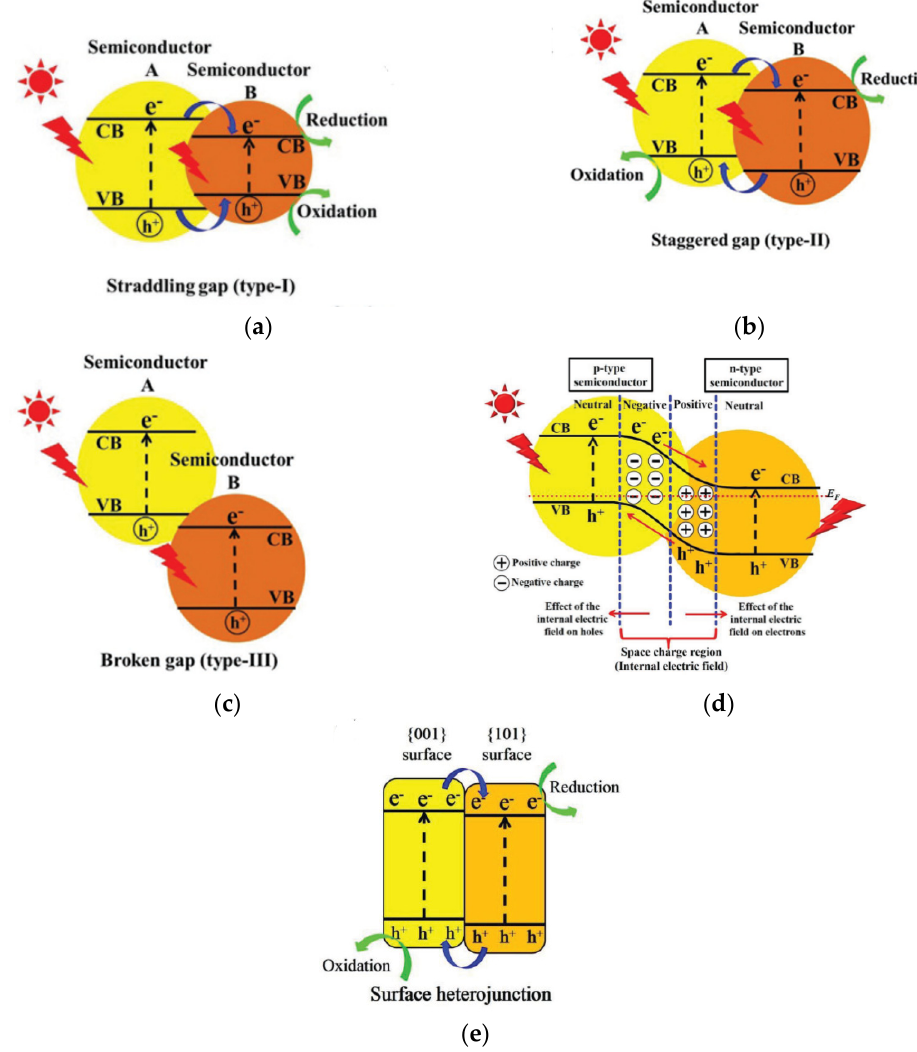
Figure 19. Several types of heterojunction ( a ) Type I; ( b ) Type II; ( c ) Type III; ( d ) Type p-n; ( e ) Type surface heterojunction [79]. Reproduced with permission from Low et al. Copyright © 2022 John Wiley & Sons, Inc.